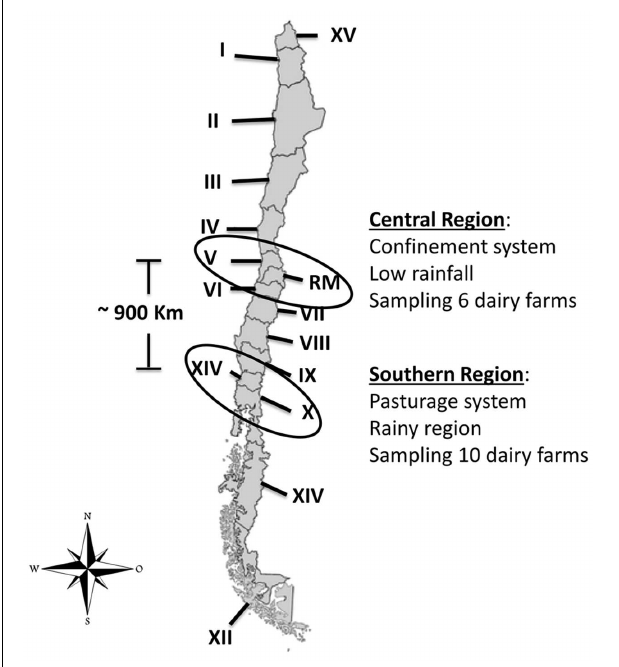
FIGURE 1 | Location in Chile of dairy farms sampled (López, 2014). Chile is divided into 15 Regions, each one is identified by a Roman numeral (I to XV). Regions sampled during the study are enclosed in